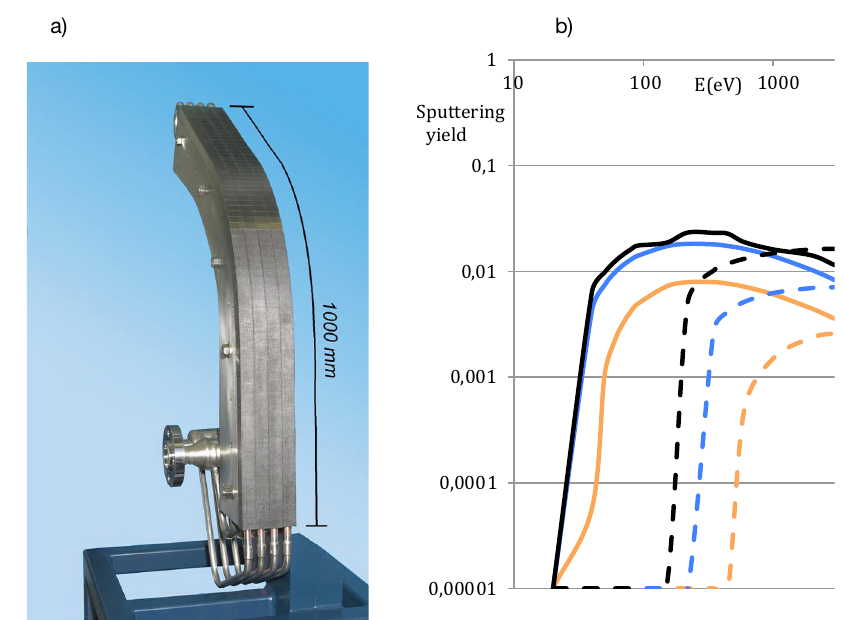
Fig. 5. – Tungsten monoblock mock up (by courtesy of EUROfusion) and physical sputtering yield vs. incident ion energy for tungsten (dashed lines) and carbon (continuous lines) under the bombardment by tritium (black), deuterium (blue) and hydrogen